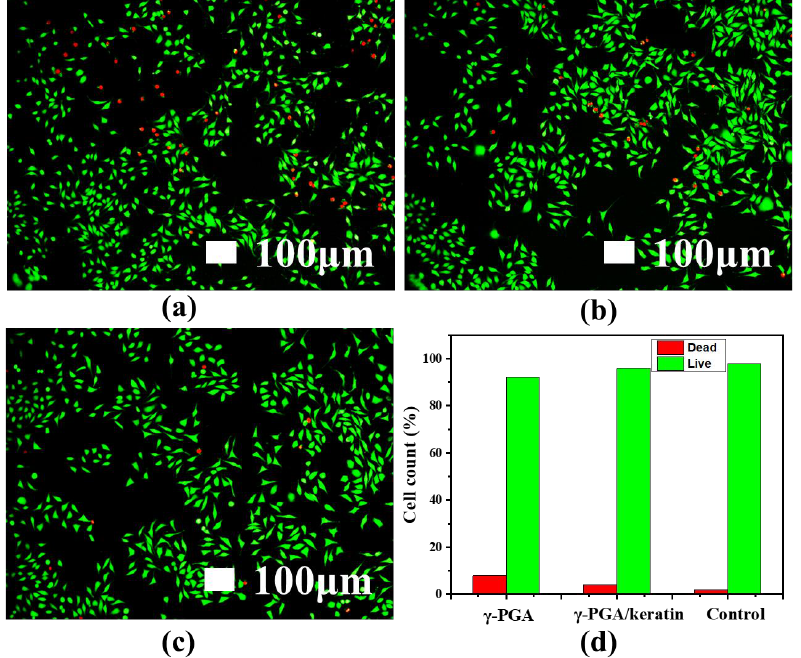
Figure 8. Fluorescence microscopy images of L929 mouse fibroblasts cultured for 1 d: ( a ) γ -PGA; ( b ) γ -PGA/keratin; ( c ) control; ( d ) the corresponding percentage of live/dead cells.